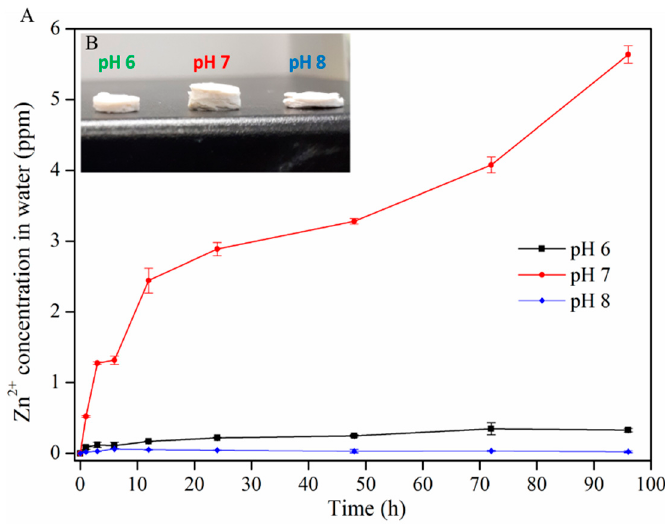
Figure 5. ( A ) Release profile of Zn 2+ ions from the CNF-ZnO composite at different pH values. (( B ) inset) CNF-ZnO specimens subjected to swelling at different conditions of pH 6, pH 7, and pH 8.